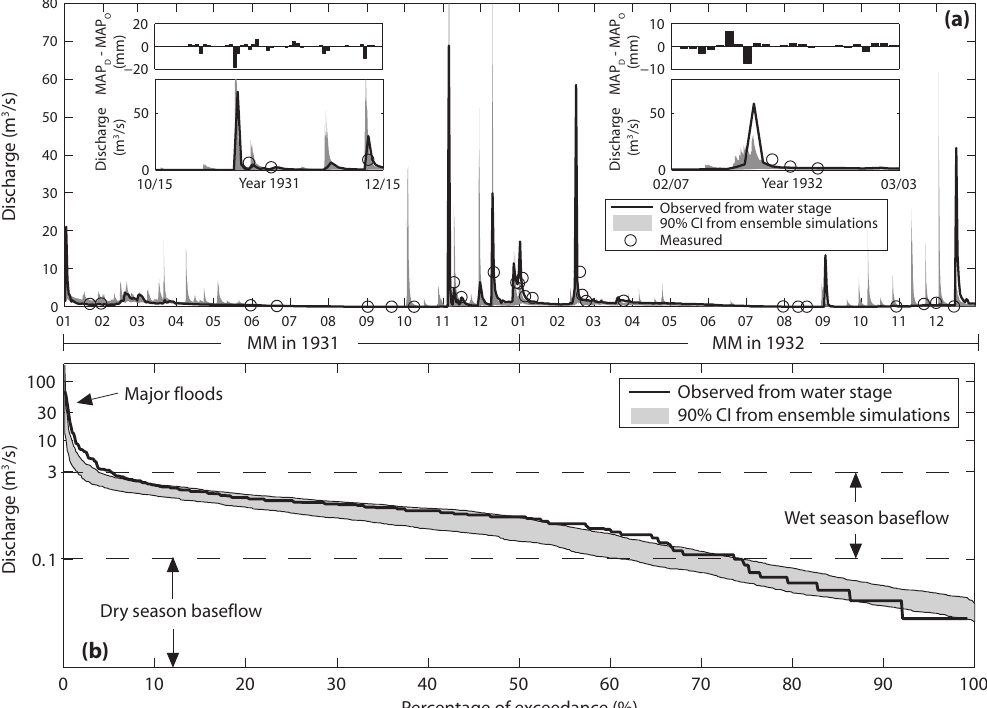
Fig. 10. Result of the tRIBS model validation (years 1931–1932). See Fig. 9 for a description of the figure content.